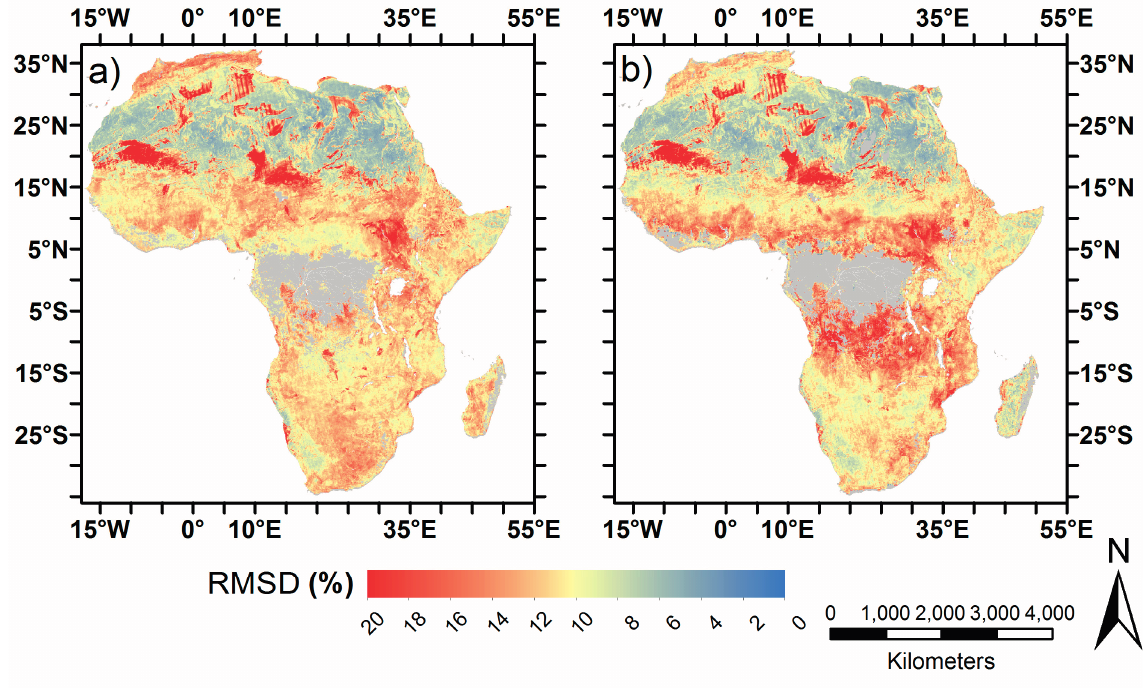
Figure 8. ( a ) The root mean square difference (RMSD) between Advanced Synthetic Aperture Radar (ASAR) Global Monitoring (GM) and the Noah model from the Global Land Data Assimilation System (GLDAS-NOAH) Surface Soil Moisture (SSM); and ( b ) the RMSD between ASAR GM and Advanced Microwave Scanning Radiometer for Earth Observing System (AMSR-E) SSM. The grey color represents the masked areas (rain forests and urban areas) or areas with insufficient data coverage (below 50 data